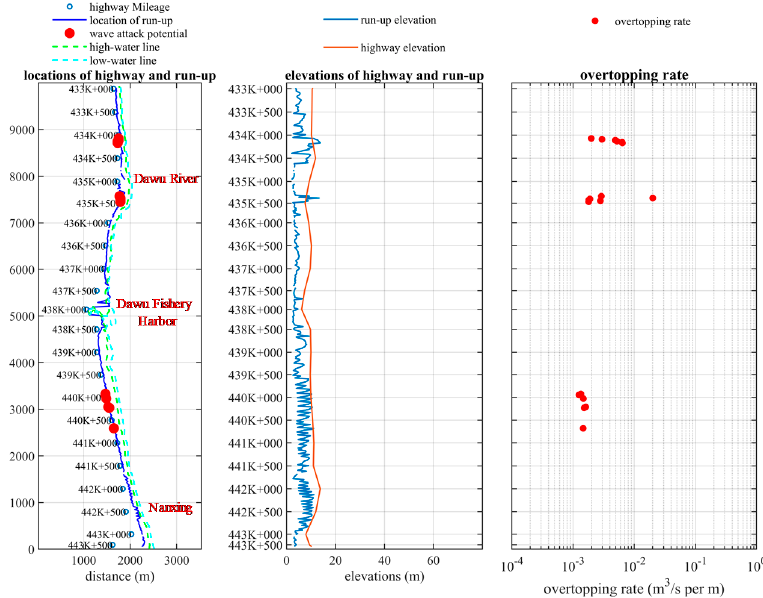
Figure 25. Map of the potential for wave attacks along the Provincial Highway in Region A. Water 2020 , 12 , 3274